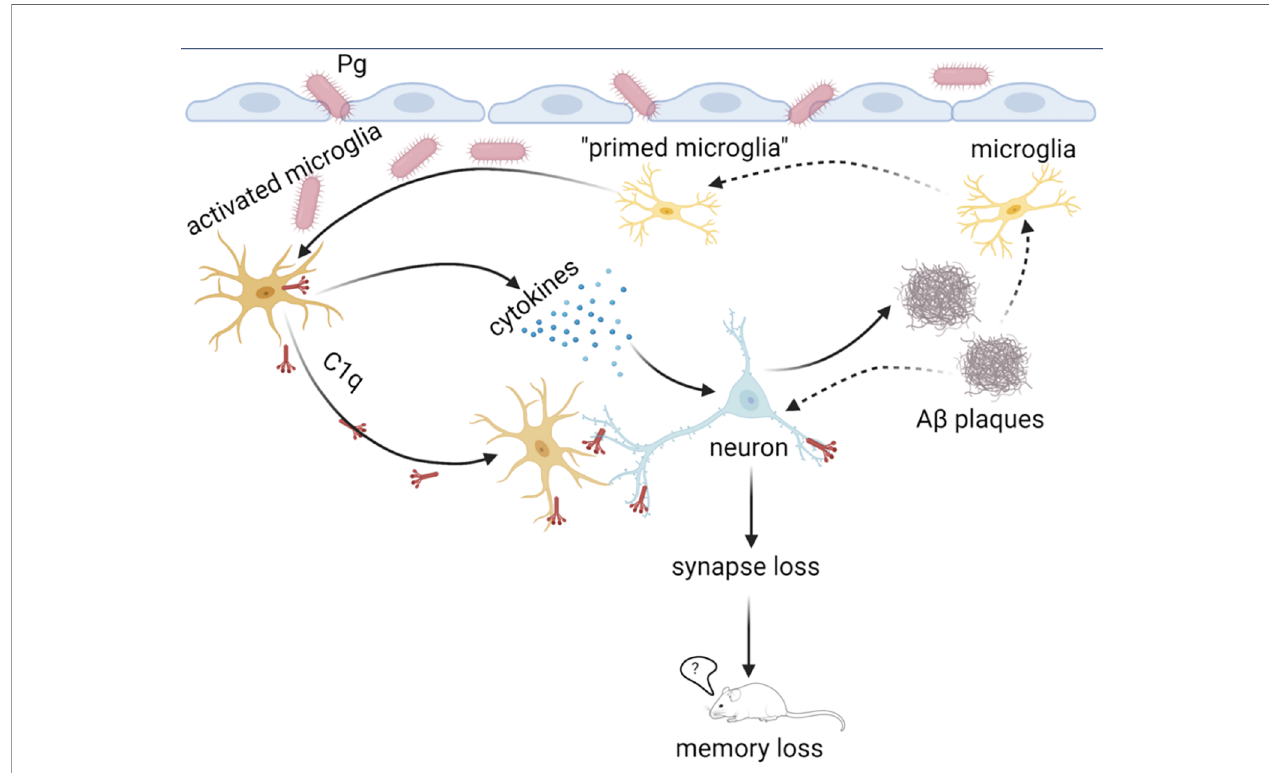
FIGURE 9 | Proposed “ two-hit ” model of AD progression in the presence of periodontitis. The accumulation of A b in the brain with AD may serve as the fi rst “ hit ” to prime microglia and induce low levels of complement activation and neuroin fl ammation. In the presence of periodontitis, periodontal pathogens may invade the brain and serve as the second “ hit ” to amplify neuroin fl ammation of the A b -primed microglia and facilitate synapse loss. Complement C1q is critical for Pg-mediated acceleration of AD progression by tagging synapses for microglia engulfment. This image was created by